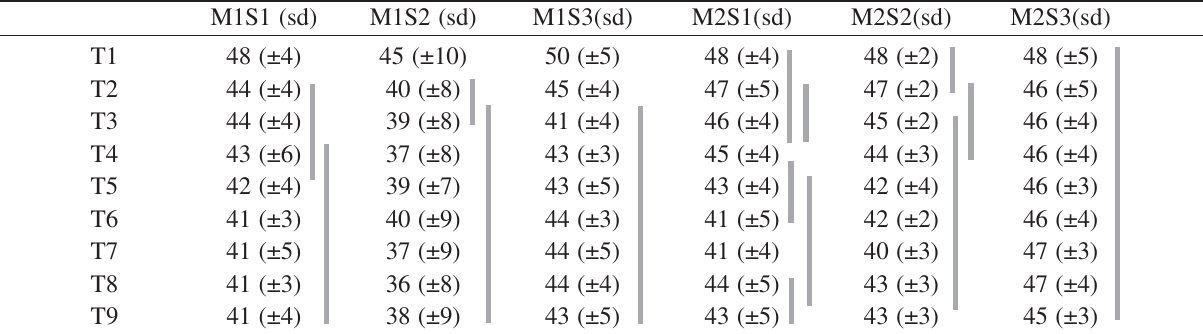
Table 2. Means and standard deviation (%) in different groups